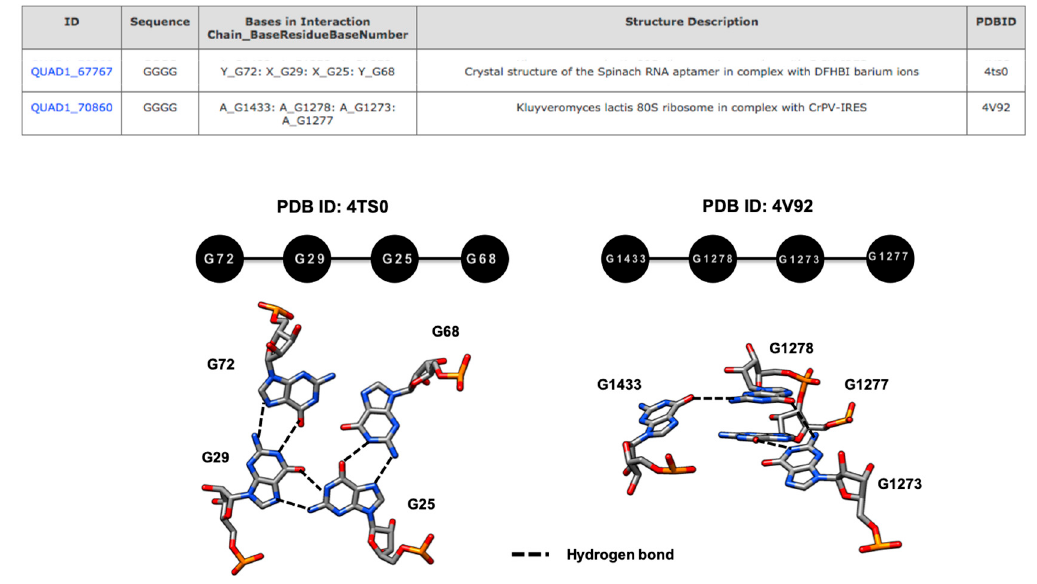
Figure 1. An example of a GGGG arrangement found in the structure of a spinach RNA aptamer (PDB ID: 4TS0) and Kluyveromyces lactis 80S ribosome (PDB ID: 4V92) that have different tertiary base arrangements, despite being retrieved using the same graph representation query of the COGNAC computer program.